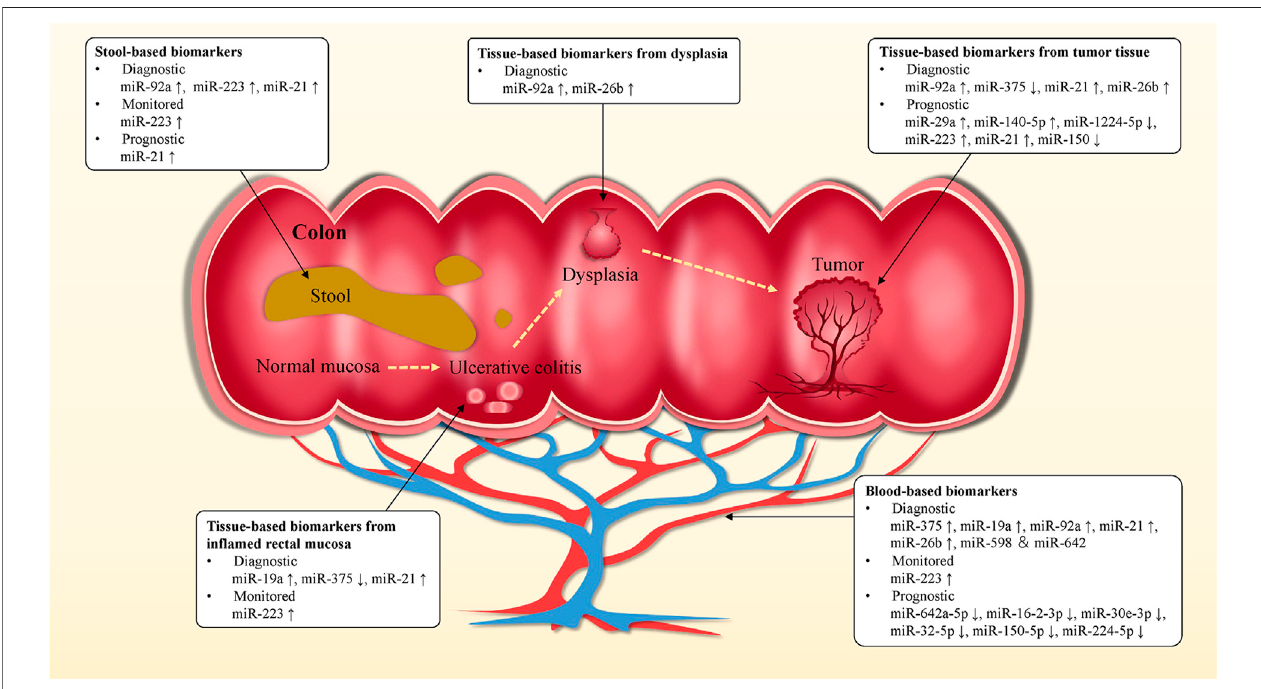
FIGURE 4 | miRNA biomarkers in UC. Blood, stool and tissue-based miRNA biomarkers might be used for the diagnosis, monitoring, prognosis of UC and the predictionofearlystageCAC,aswellastoguideclinicaltreatmentandmedicationstrategies.miRNAbiomarkerscouldbeofvalueinimprovingsurvivalandcureratesin UC and CAC